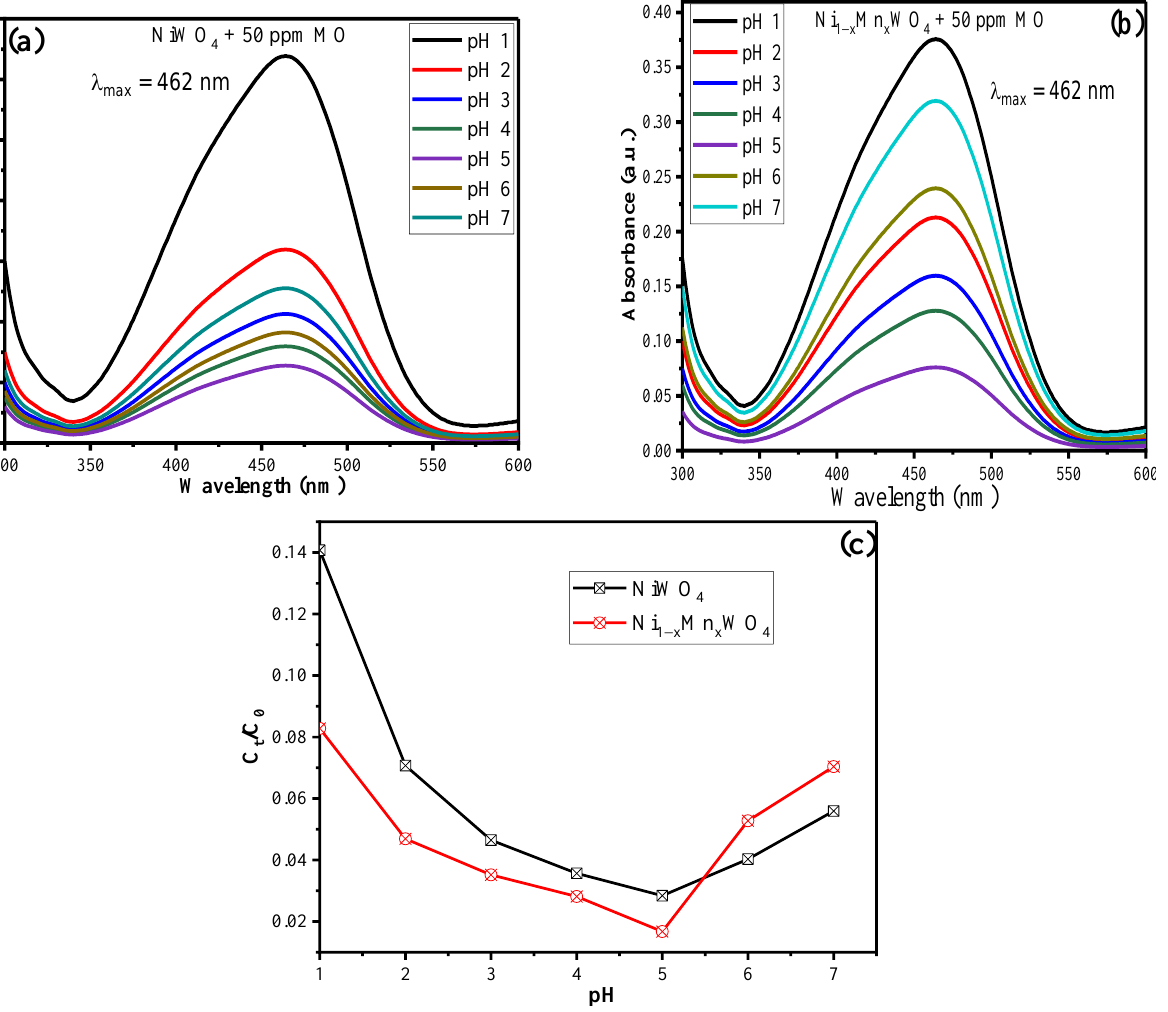
Figure 6. UV – Vis spectra of ( a ) NiWO 4 ( b ) Ni 1 − x Mn x WO 4 NC and ( c ) C t /C 0 graph vs. pH depicting rate of MO (50 ppm) degradation for 70 min of visible light irradiation.